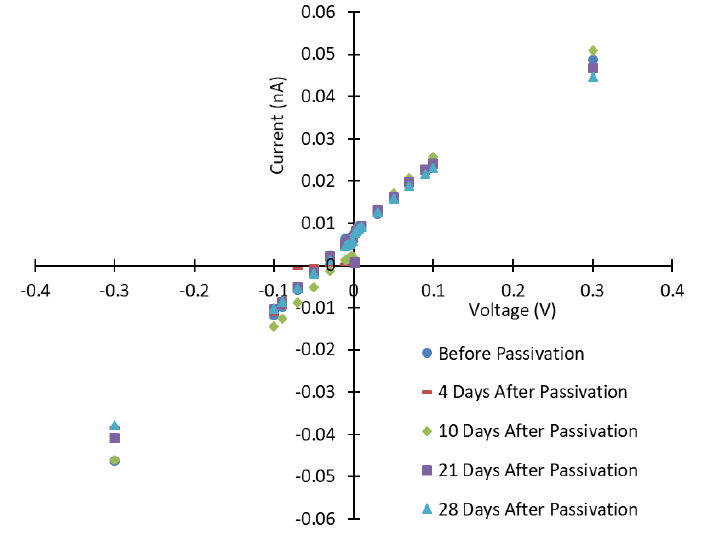
Figure 3. Current-voltage graph for very low voltages in the range − 0.3 V and 0.3 V.